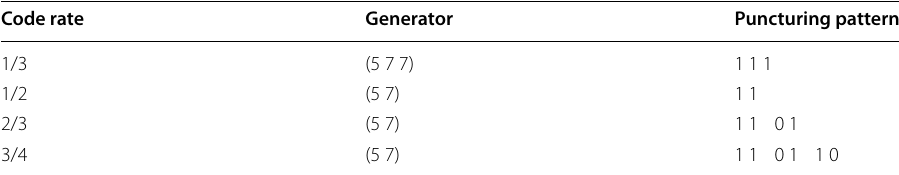
Table 2 Puncturing patterns for codes with constraint length K cc in octal